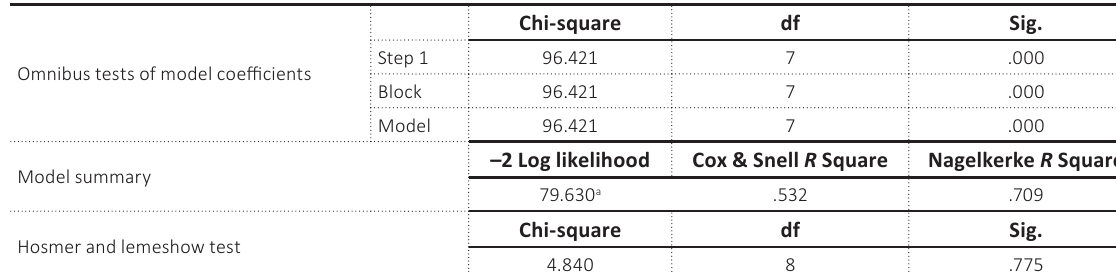
Table 7. Omnibus tests of model